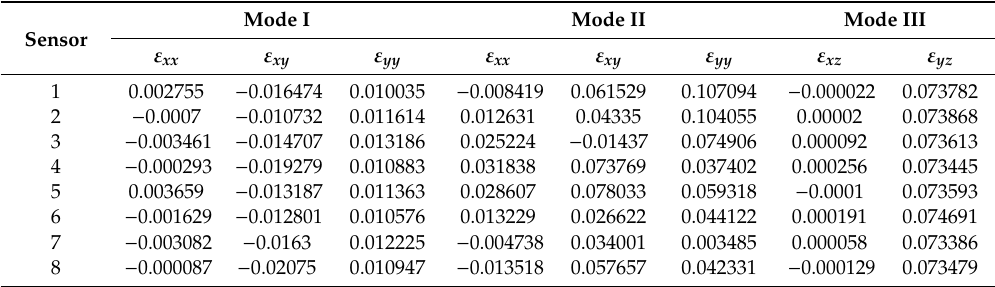
Table 1. Calculated strains (unit µ ) of the eight sensors in composite plate with a hole (BEM). Sensor